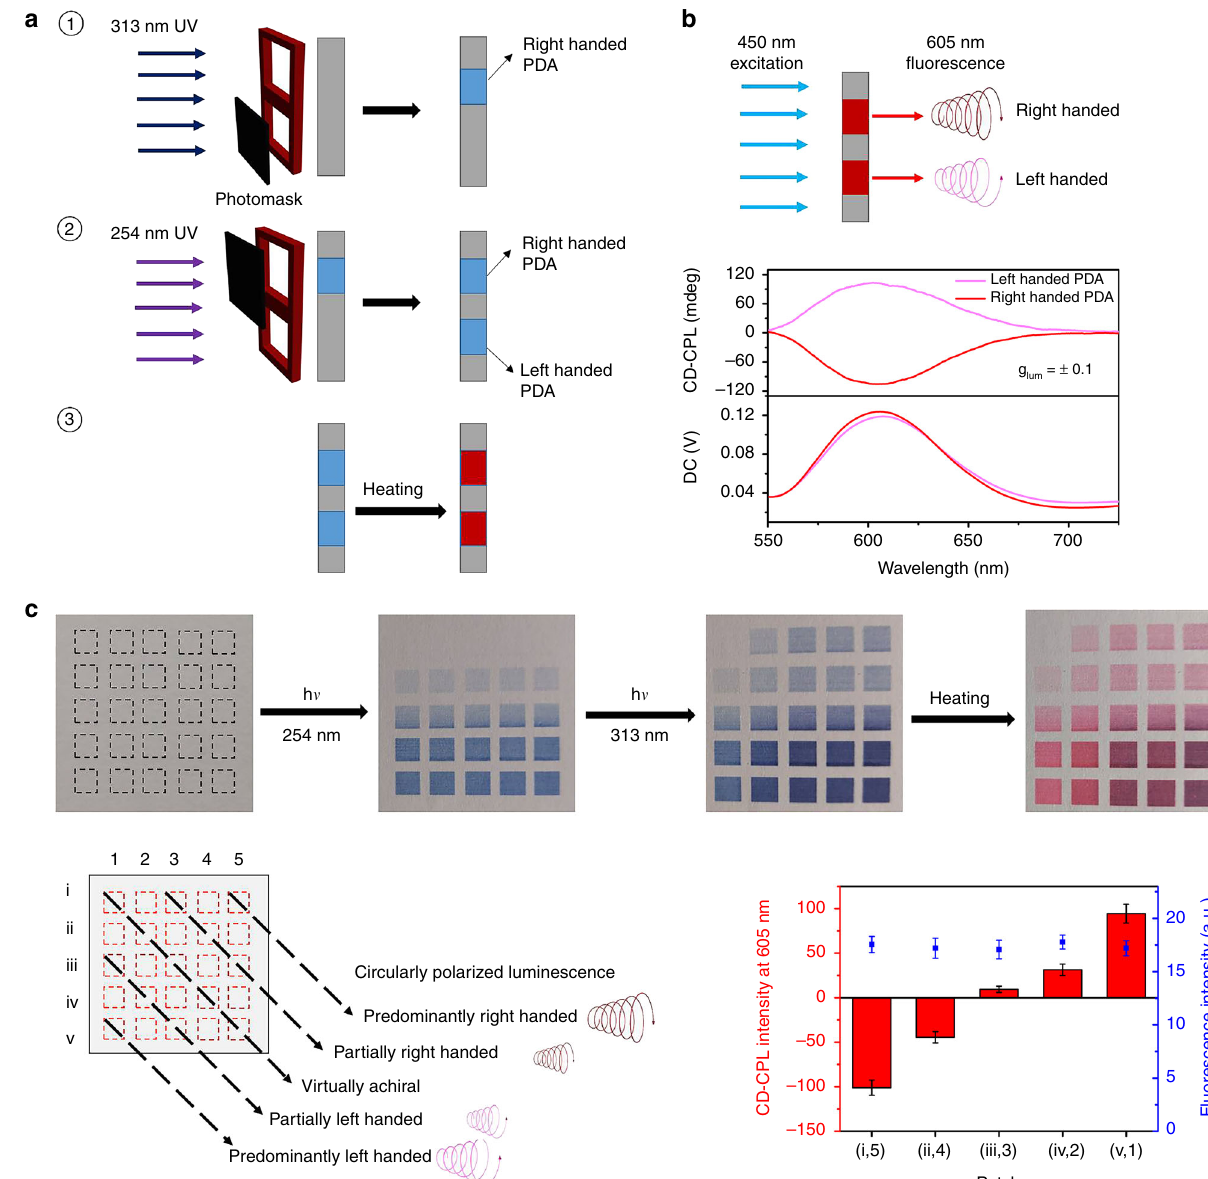
Fig. 5 Programmable chiral PDA arrays with circularly polarized fl uorescence. a Two-step irradiation to pattern right-handed and left-handed PDA sequentially on a fi lm. b Either right- or left-circularly polarized fl uorescence emitted with high asymmetry factors ( g lum = ±0.1 at ~605 nm). c A matrix of PDA patches with tailorable chirality. The patches in each row are irradiated with varying amounts of 254 nm and in each column with varying amounts of 313 nm, resulting in a 2D matrix of PDA patches each with its own unique combination of chirality and intensity. For example, right-handed PDA is found in the northeast corner, left-handed PDA in the southwest corner, and achiral PDA in the diagonal patches; while chirality varies along the diagonal direction of northeast-southwest, the intensity of fl uorescence increases step-wisely along the other diagonal from northwest to southeast. At least three experiments were performed to obtain the average signals, and error bars represented standard deviations of measured